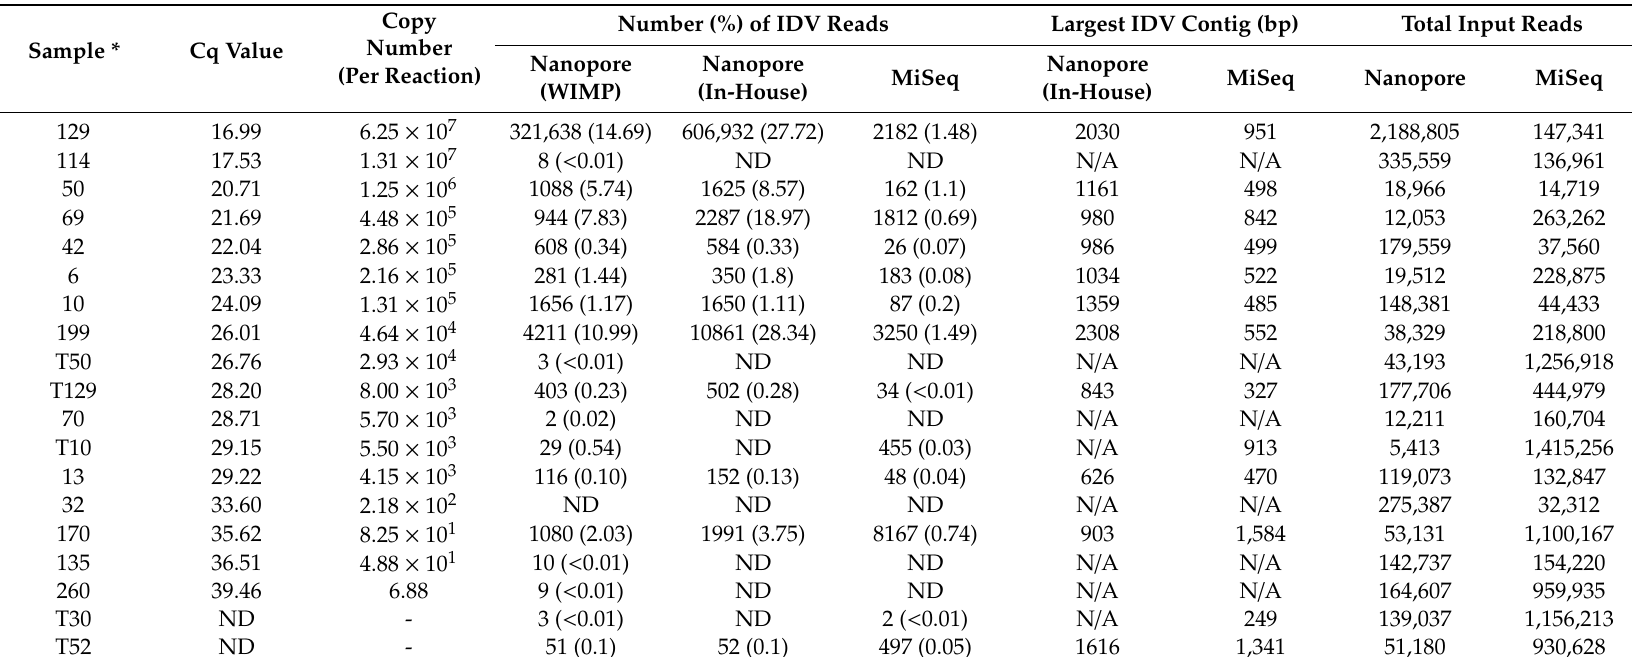
Table 1. Summary of data from Nanopore, MiSeq and qPCR on detection of influenza D virus (IDV) for each individual